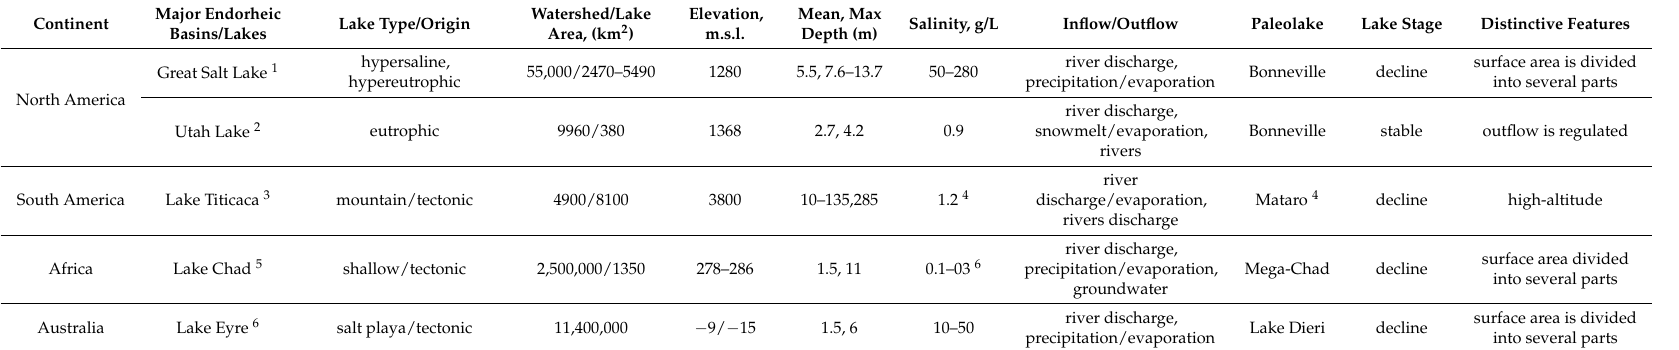
Table 1. Endorheic basins and lakes (Excluding Eurasia and Central Asia, see Figure